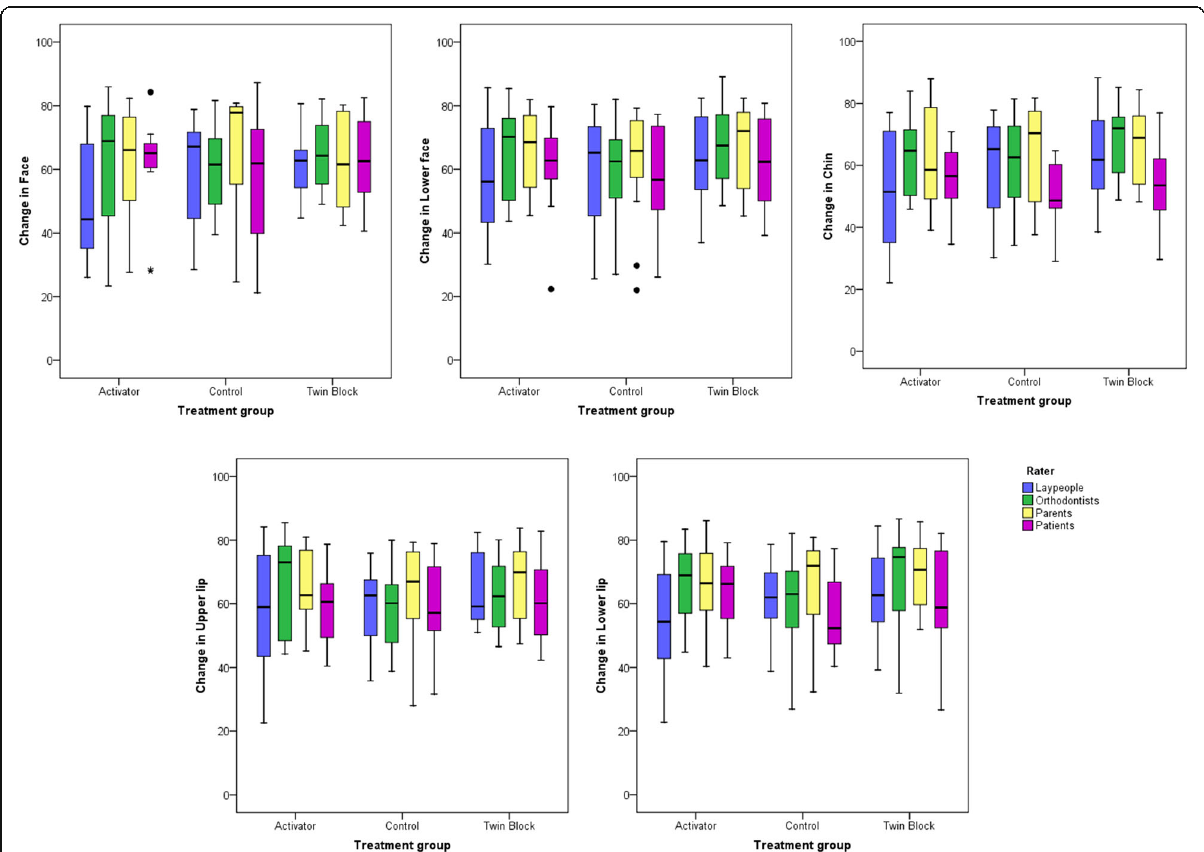
Fig. 3 Box plots showing the assessed changes from pre- to post-treatment condition in VAS values ( y -axis), grouped by treatment approach. The upper limit of the black line represents the maximum value, the lower limit the minimum value, the boxed the interquartile range, and the horizontal black line the median value. Outliers (> ± 3SD) are shown as black